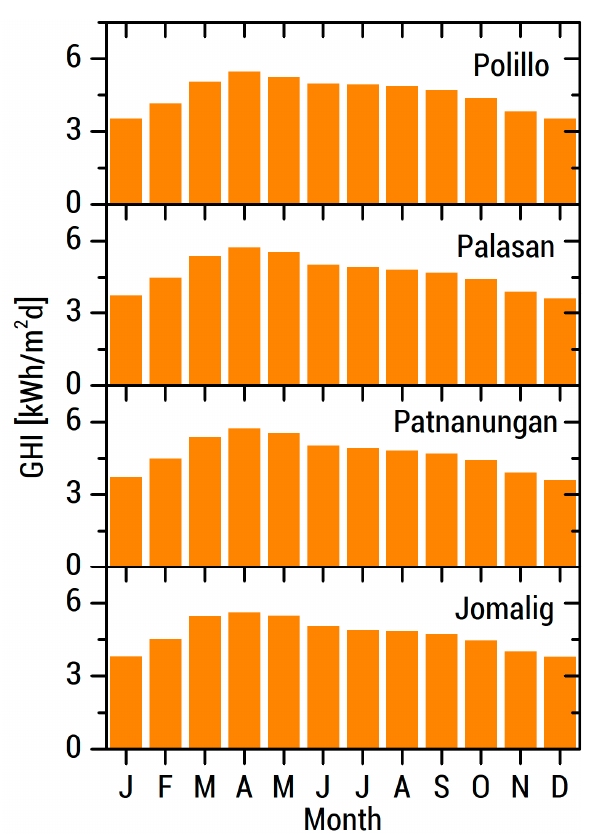
Figure A1. Monthly average global horizontal irradiance (GHI) profiles in the selected islands.